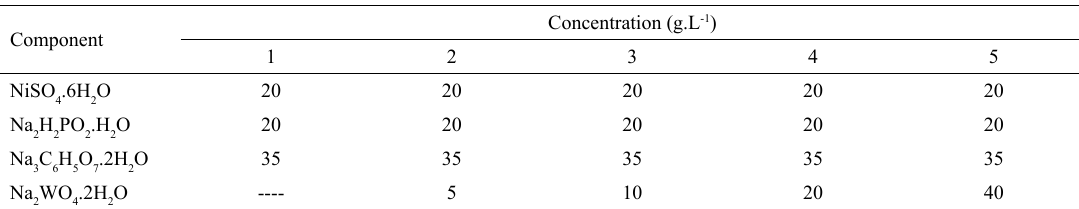
Table 1. Composition of the plating